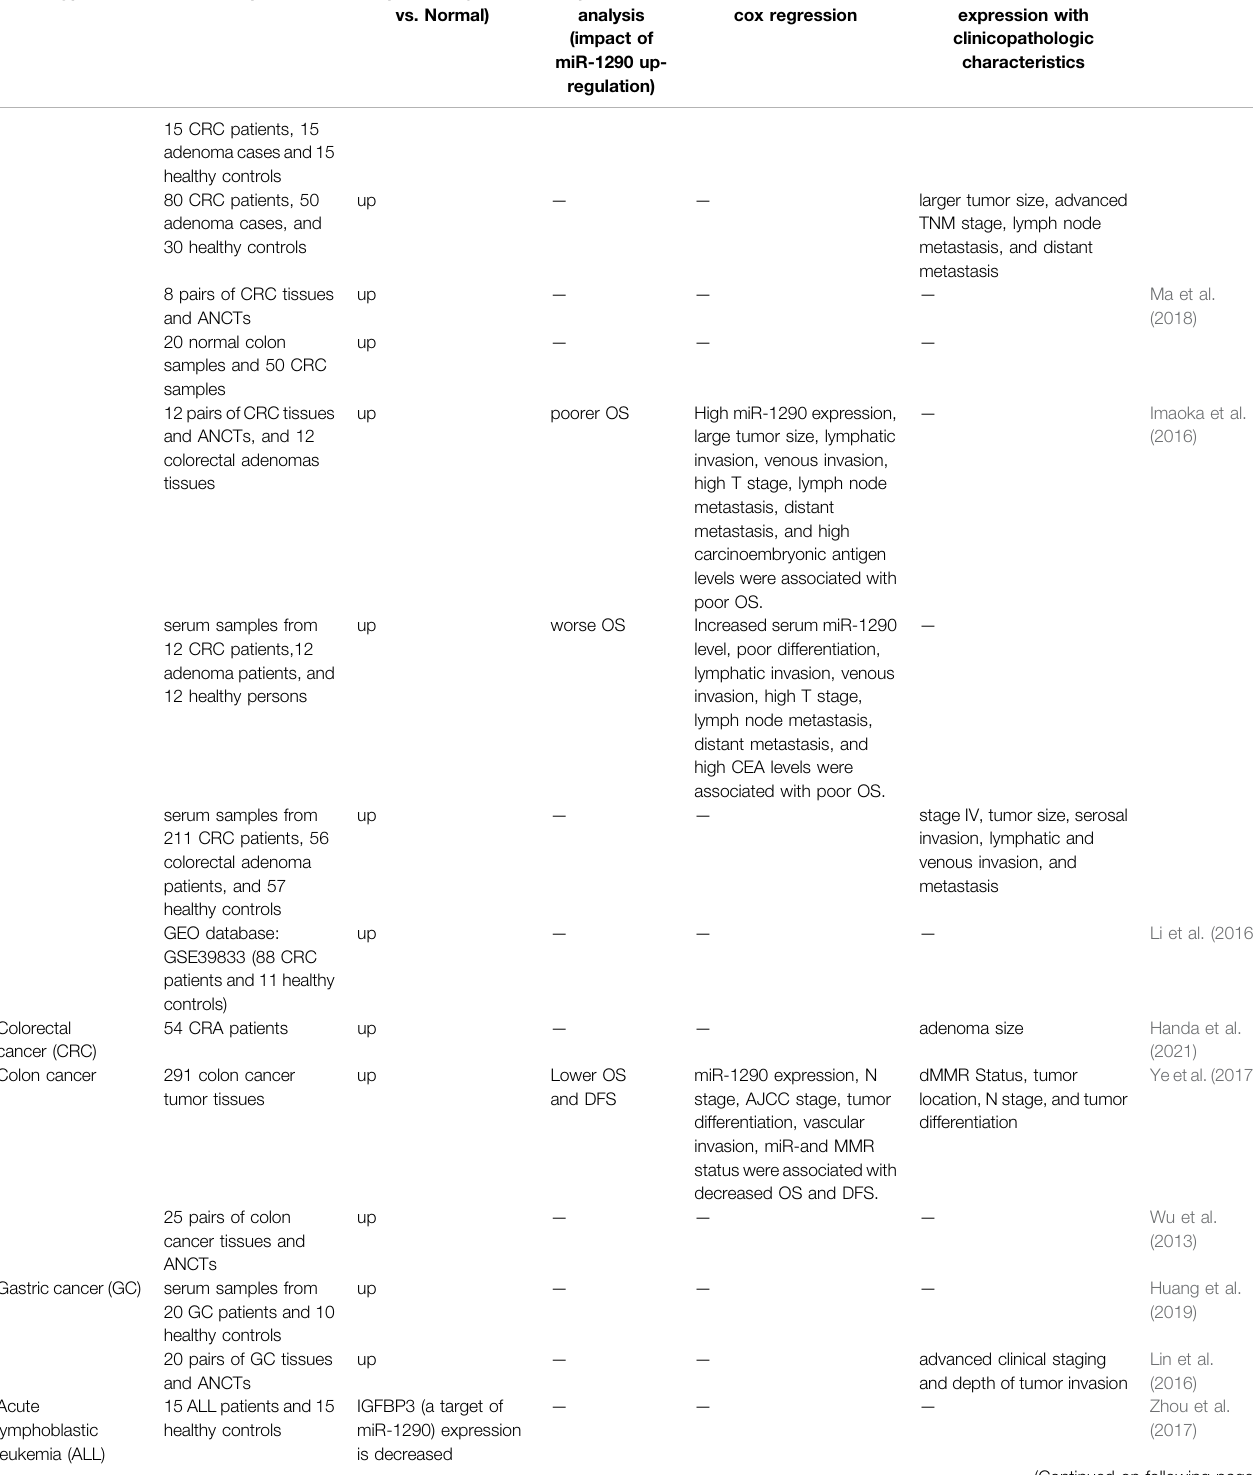
cancer, CRA: colorectal adenoma, HGSOC: high grade serous ovarian cancer, EOC: epithelial ovarian cancer, HGSOC: high grade serous ovarian